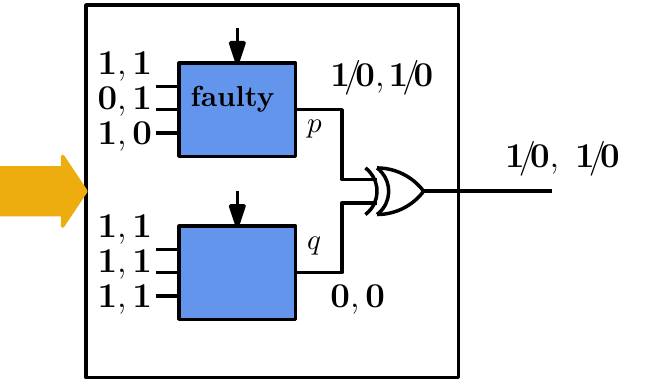
Figure 4. Combinational circuit featuring a faulty cell. Two possible input vectors are shown separated by commas. The notation 1/0 denotes that the considered signal has the values 1 and 0 in the fault-free and in the faulty circuit,